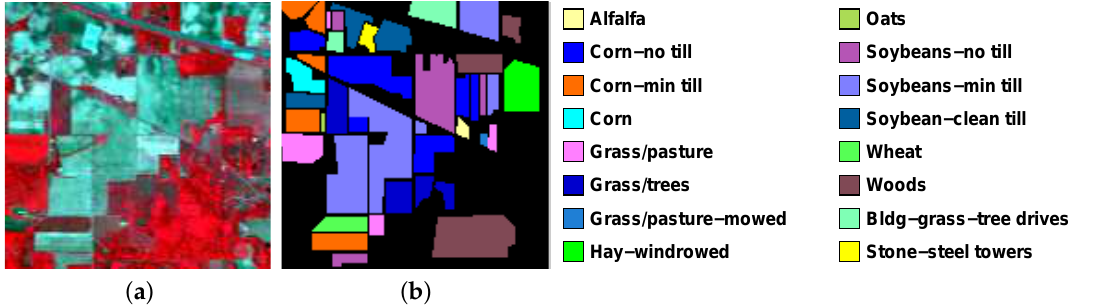
Figure 3. AVIRIS Indian Pines dataset. ( a ) RGB composite image. ( b ) Ground reference